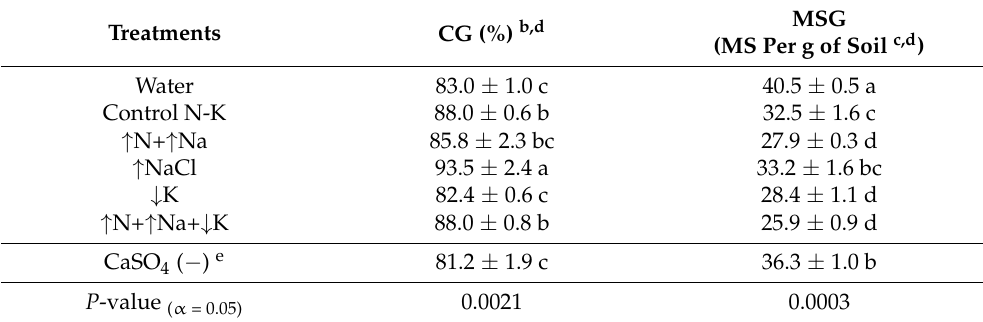
Table 4. Effects of root exudates a from non-inoculated plants on conidia germination of V. dahliae isolate V323 and microsclerotia viability in naturally infested soil